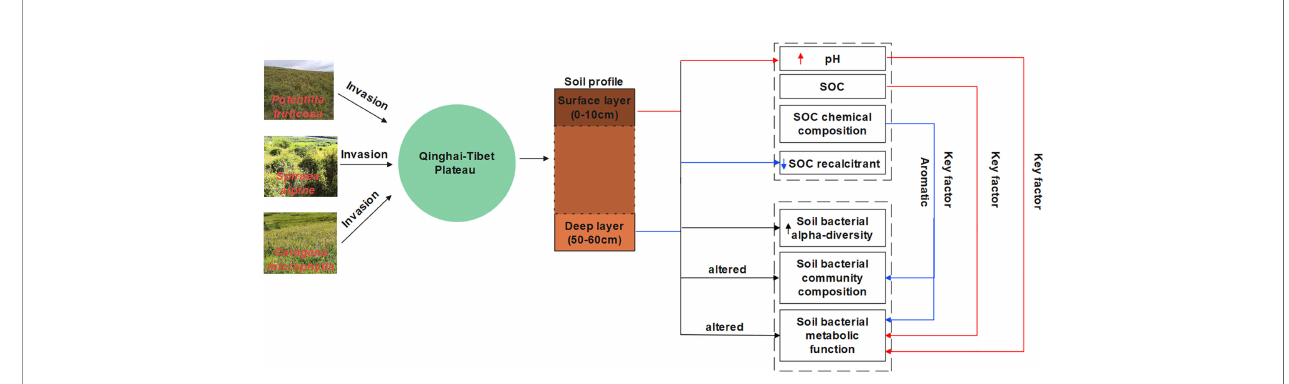
FIGURE 10 | The summary of our fi ndings. The red line represents the surface layer, the blue represents the deep layer, and black represents